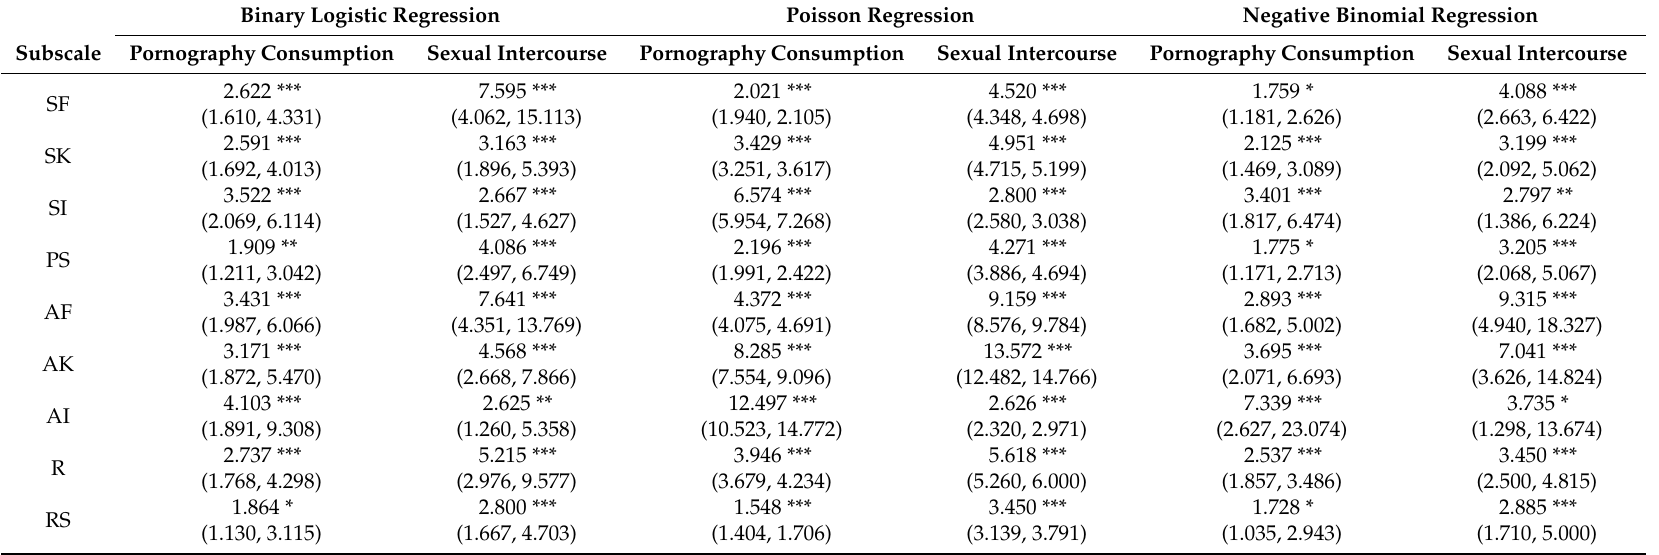
Table 5. Regression